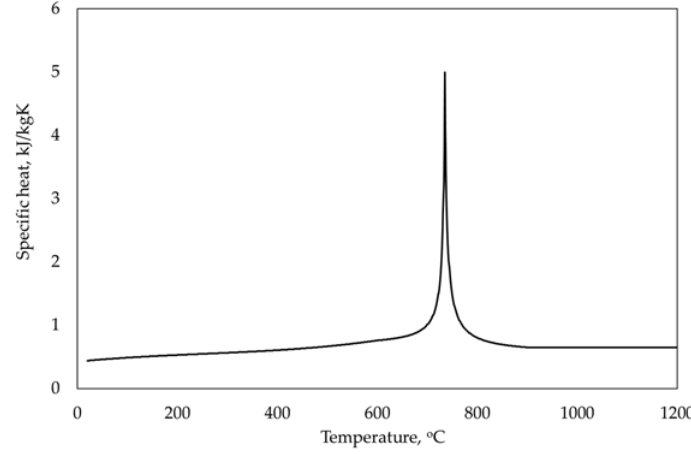
Figure 11. Specific heat of steel.